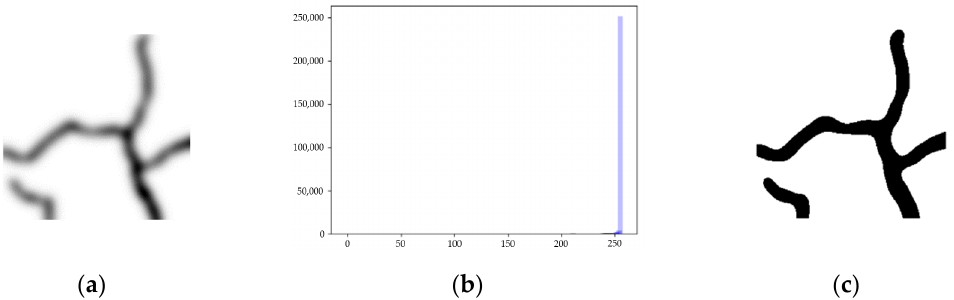
Figure 7. Otsu threshold segmentation results. ( a ) Image after Gaussian blur, ( b ) threshold distribu- tion of images, ( c ) Otsu image after threshold segmentation.